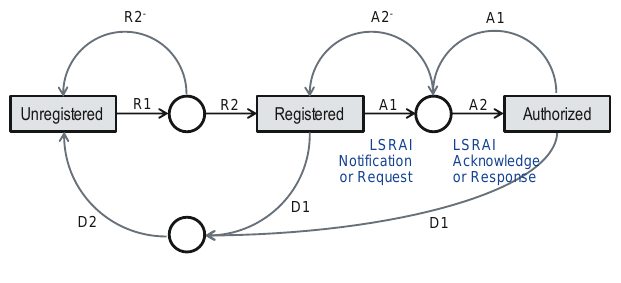
Figure 5. State diagram for the